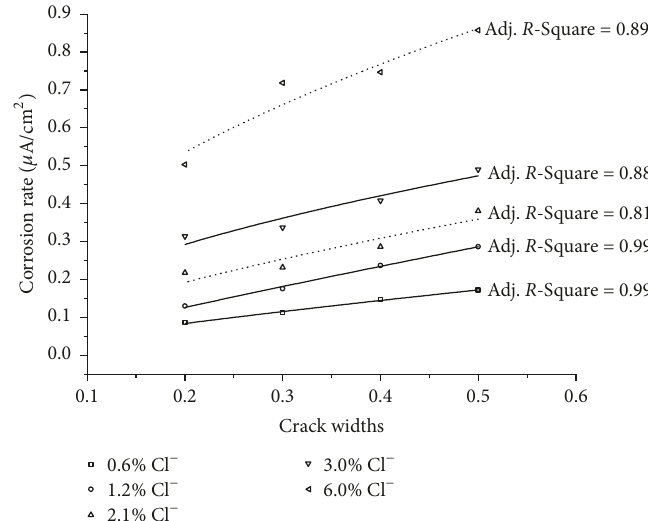
Figure 7: Average corrosion rate versus crack width (mm).